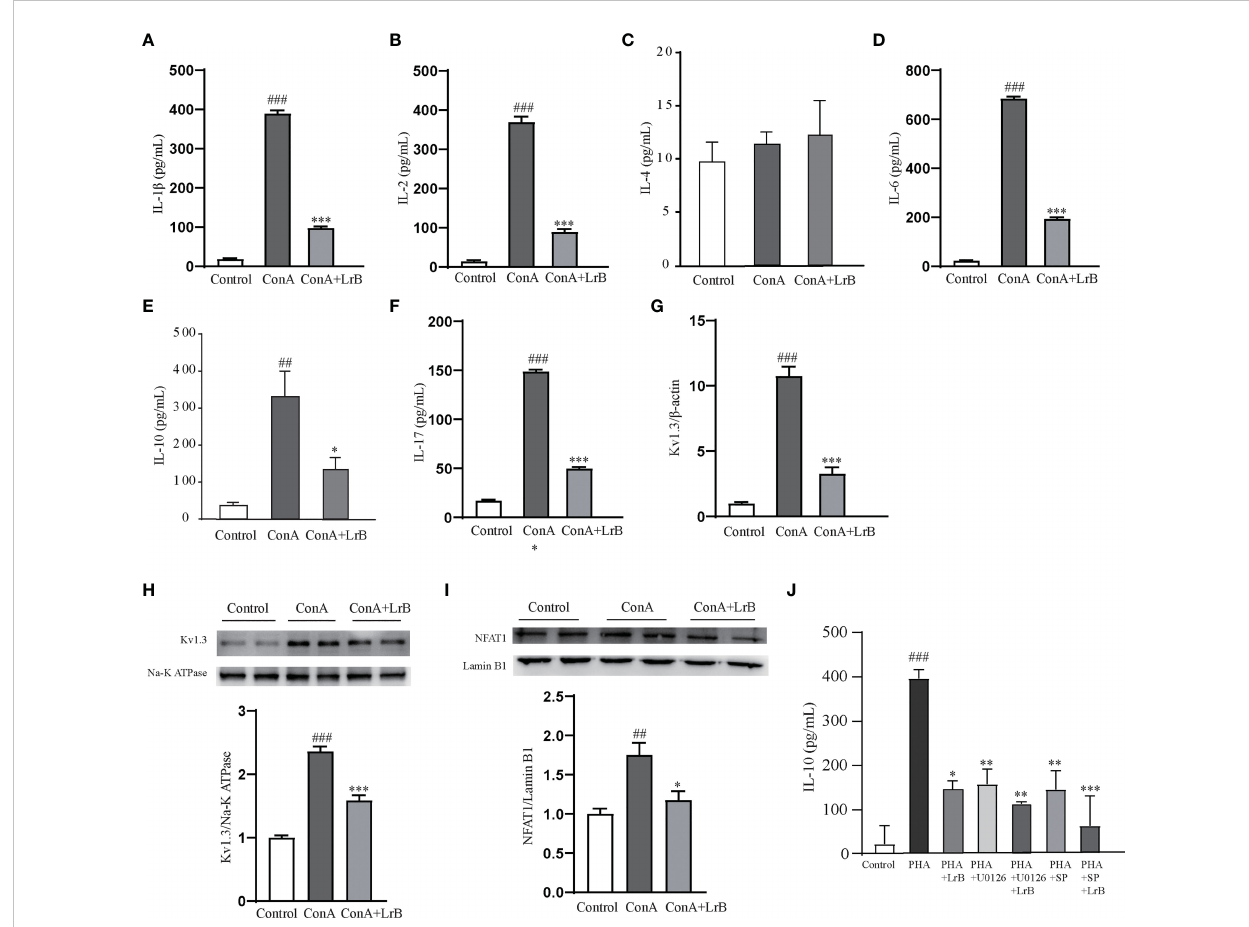
FIGURE 8 LrB decreased Kv1.3 expression and NFAT1 activation in PBMCs. (A) The concentration of IL-1 b released by cultured PBMCs detected by ELISA (n=5). (B) The concentration of IL-2 released by cultured PBMCs (n = 5). (C) The concentration of IL-4 released by cultured PBMCs (n = 5). (D) . The concentration of IL-6 released by cultured PBMCs (n = 5). (E) The concentration of IL-10 released by cultured PBMCs (n=5). (E) Kv1.3 mRNA in PBMCs as shown by qPCR (n = 4). (F) The concentration of IL-17 released by cultured PBMCs (n=5). (G) Kv1.3 mRNA in PBMCs as shown by qPCR (n = 4). (H) Kv1.3 protein on the cell membrane was analyzed by western blot (n = 4). (I) NFAT1 in the nuclear region was analyzed by western blot (n=4). (J) The cytokine IL-10 released by PBMCs under the treatment of ERK inhibitor U0126, JNK inhibitor SP600125 and LrB (n = 3). (Results are expressed as the mean ± SEM, and tested with One Way ANOVA. ##, P ≤ 0.01, ###, P ≤ 0.001, compared to the Control group; * P ≤ 0.05, ** P ≤ 0.05, *** P ≤ 0.001, compared to the ConA stimulus